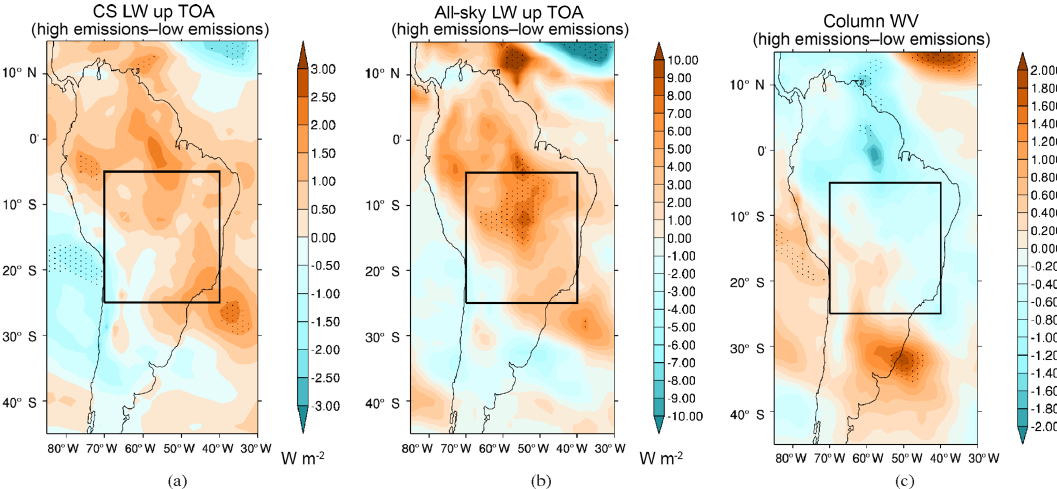
Figure 11. September mean differences: (a) The difference between high and low emissions case for the clear-sky outgoing LW radiation at TOA. (b) The difference between high and low emissions case for the all-sky outgoing LW radiation at TOA (note the colour scales for clear sky and all sky are different). (c) The difference between high and low emissions case for the column integrated water